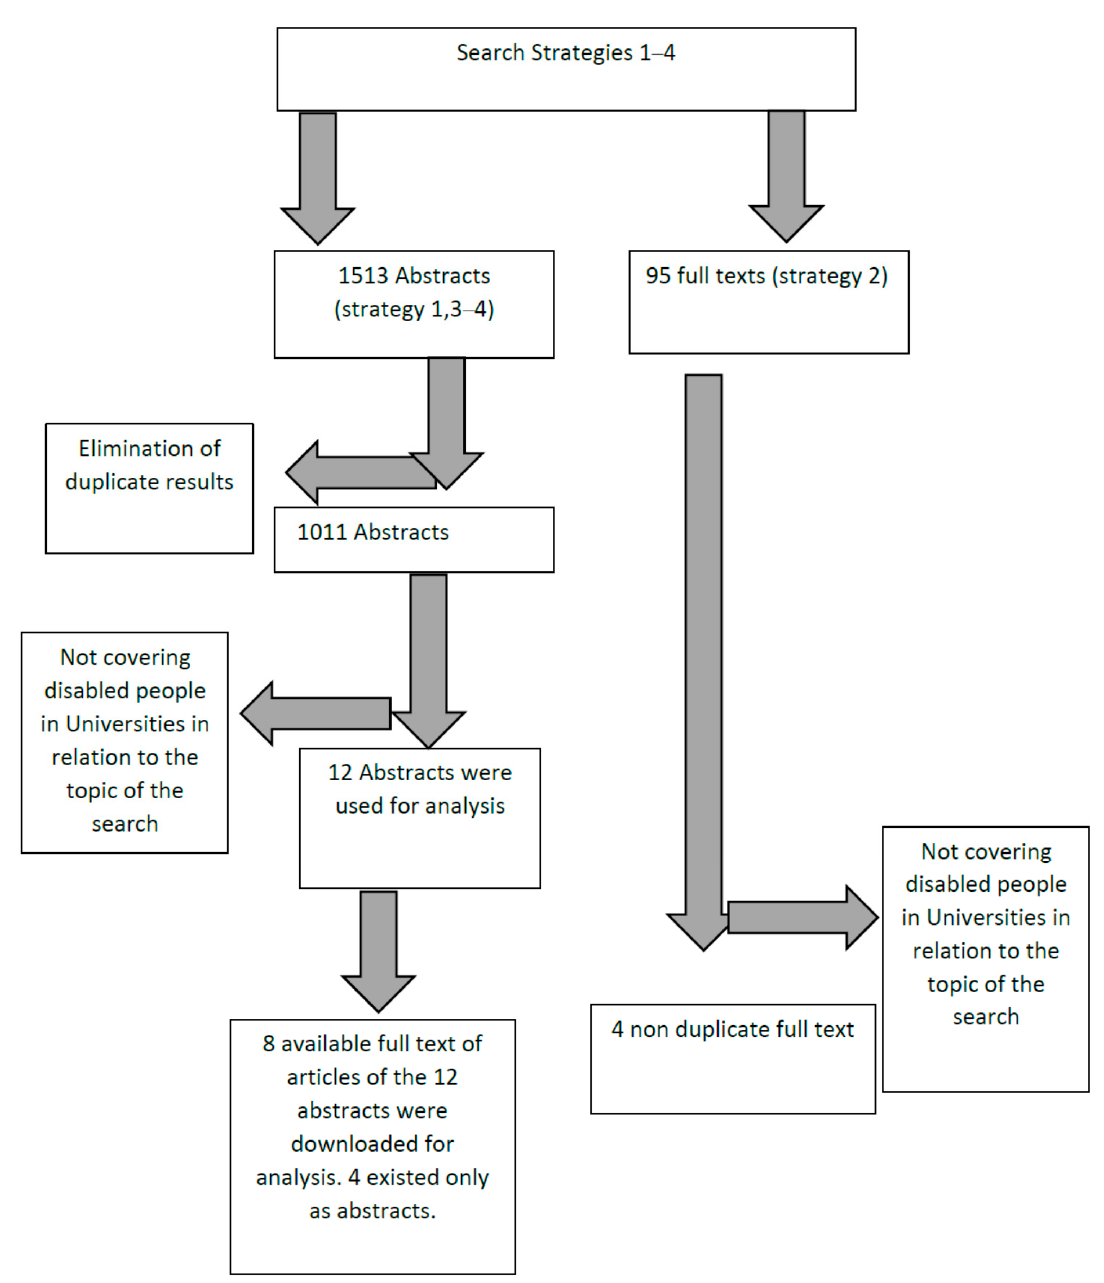
Figure 1. The flow chart of the selection of academic abstracts and full text articles for qualitative analysis.